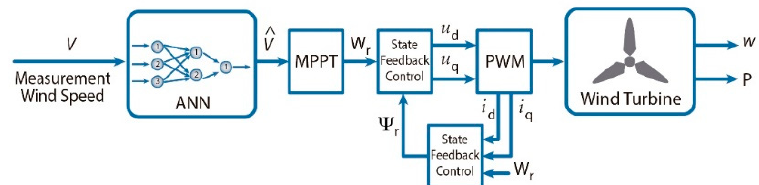
Figure 13. Control strategy where an Artificial Neural Network (ANN) is used to estimate the wind speed and thus buffer the discontinuity and slow response of an anemometer [68].